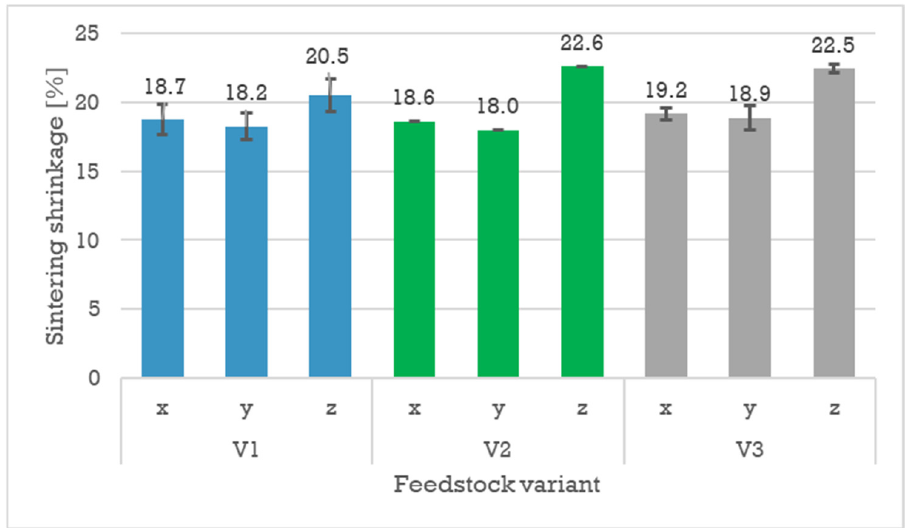
Figure 9. Sintering shrinkage of the V1, V2 and V3 printed cubic samples.